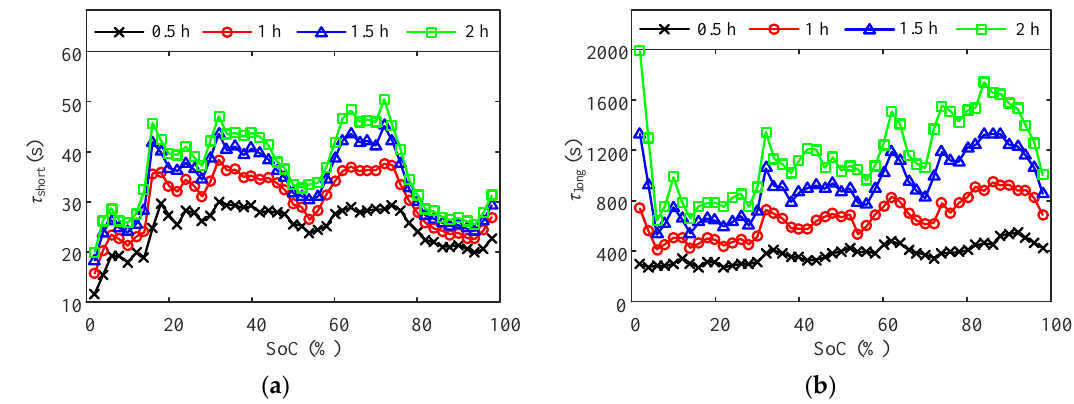
Figure 9. Curve fitting results of V P during the rest period of the discharging pulse-rest test at 60% SoC : ( a ) the overall result; ( b ) a close look at the transient part at the beginning.